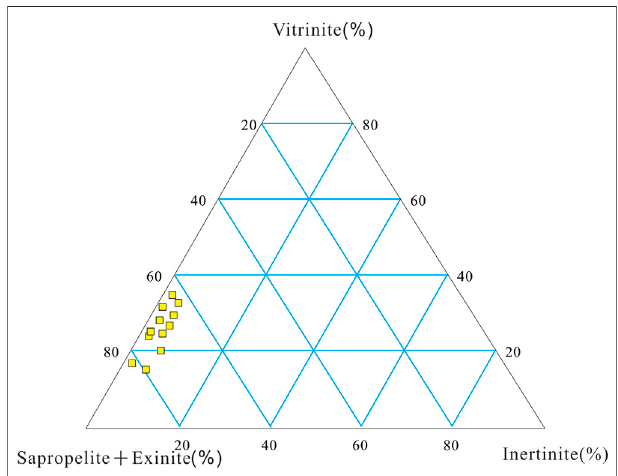
FIGURE 5 | Distribution of kerogen microscopic composition in XJC 1 well.